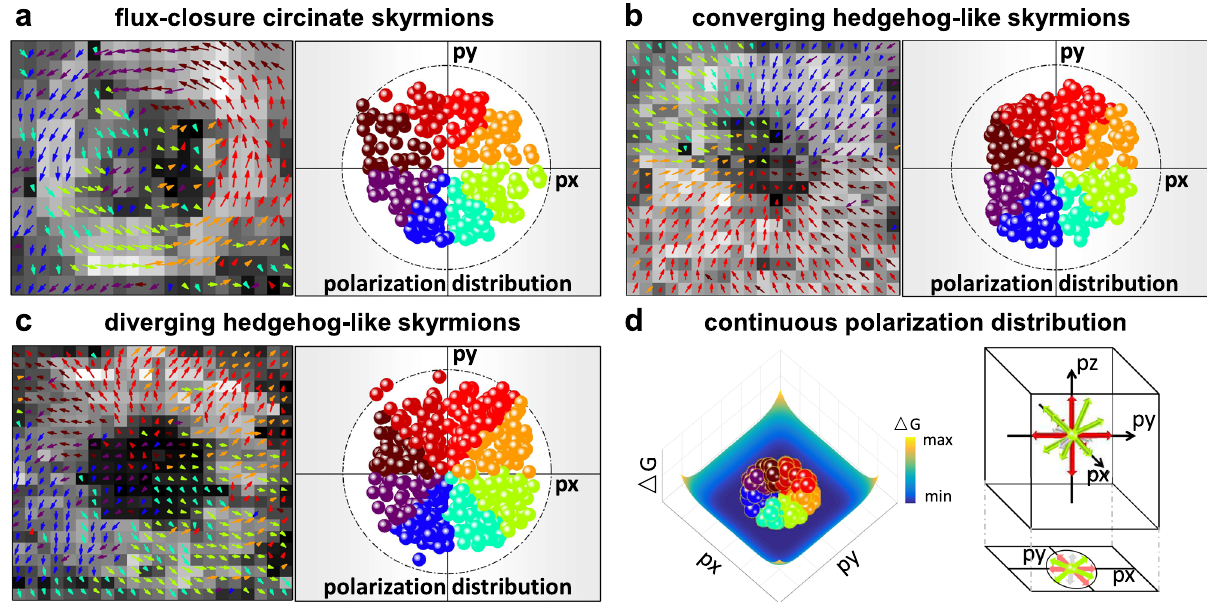
Fig. 2 Polymorphous con fi gurations of bubble domains. Polymorphous conformational topologies of polarization vectors observed in bubble domains, with three representative polar skyrmions shown, including a continuous electric dipole rotation in a circinate fl ux-closure Bloch-like form, b converging hedgehog-like form, and c diverging hedgehog-like form. The polarization vectors are fi lled with different colors according to their angles (left), which exhibit a continuous distribution (right). The grid background shows the corresponding magnitude of each vector. d Phenomenological illustration of the continuous polarization distribution. Due to the highly fl attened free-energy landscape, the coexistence of continuously distributed polarizations is